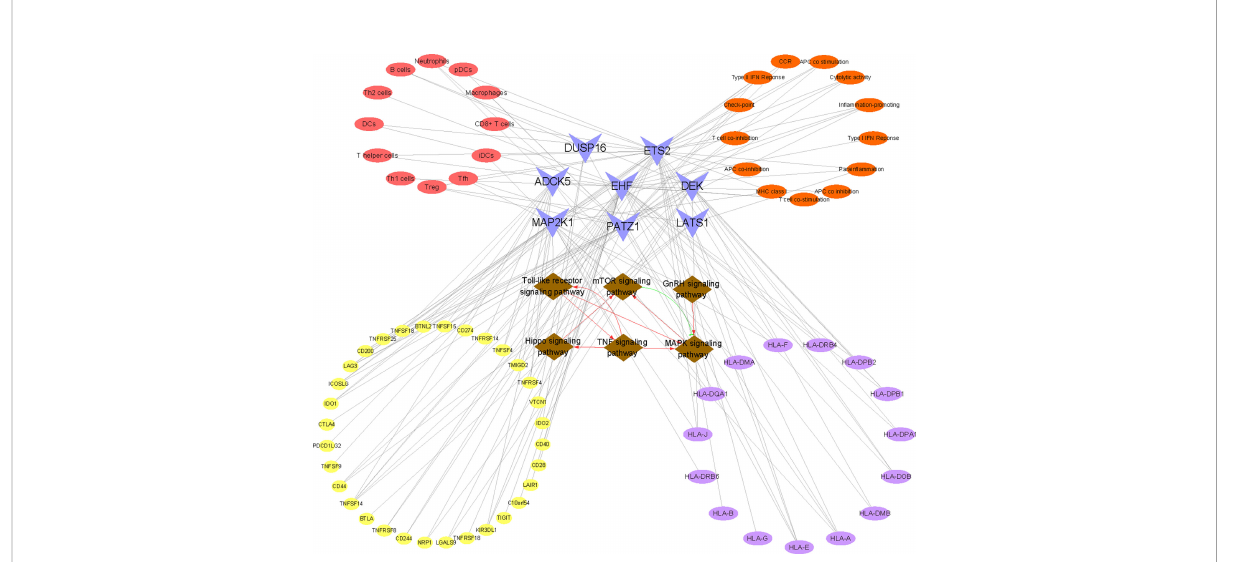
FIGURE 9 Construction of the “ KEGG pathway – RIF signature genes – immune landscape ” association network. The network consists of 86 nodes and 160 edges. Brown nodes represent the KEGG pathway, blue nodes represent RIF signature genes, red nodes represent immune cell type, orange nodes represent immune function, purple nodes represent HLA-related genes, and yellow nodes represent immune checkpoint-related genes. The black lines represent the relationships between nodes. The red lines represent facilitation effects between pathways, and the green lines represent inhibition between